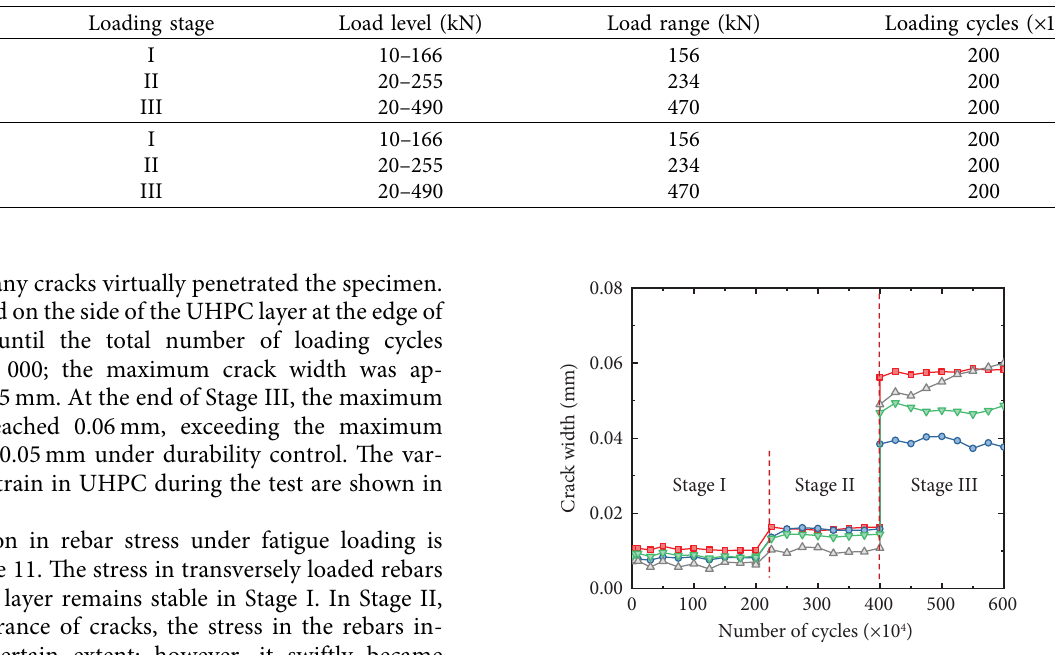
Table 3: Fatigue loading protocol.